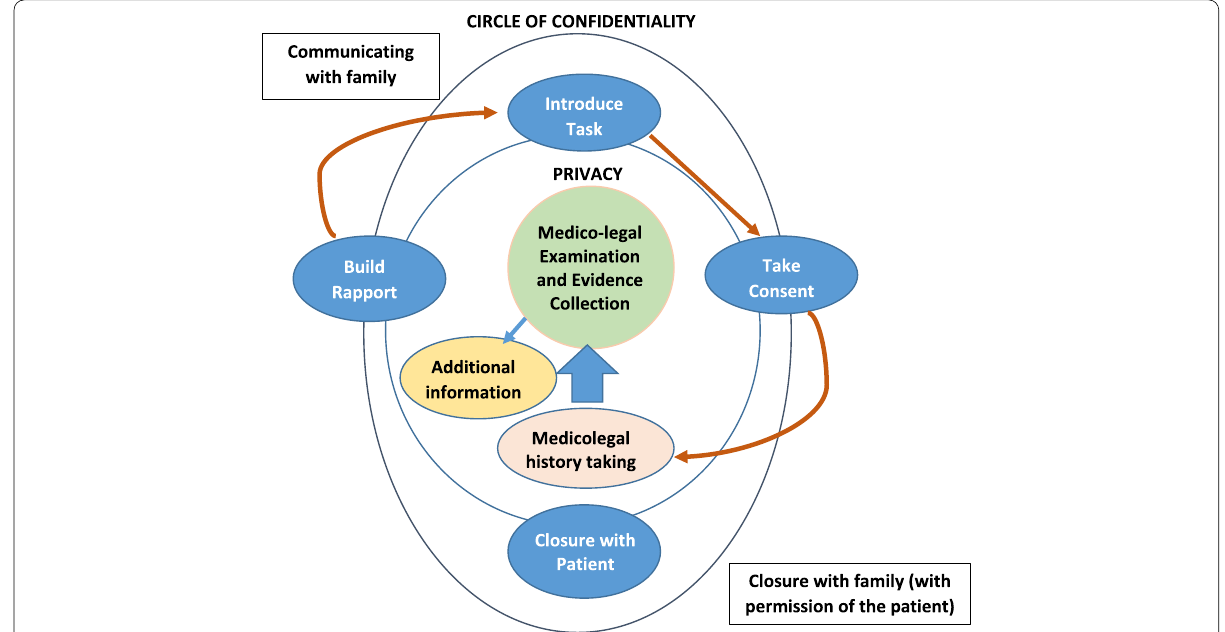
Fig. 1 The phases of medico-legal history collection, examination and evidence